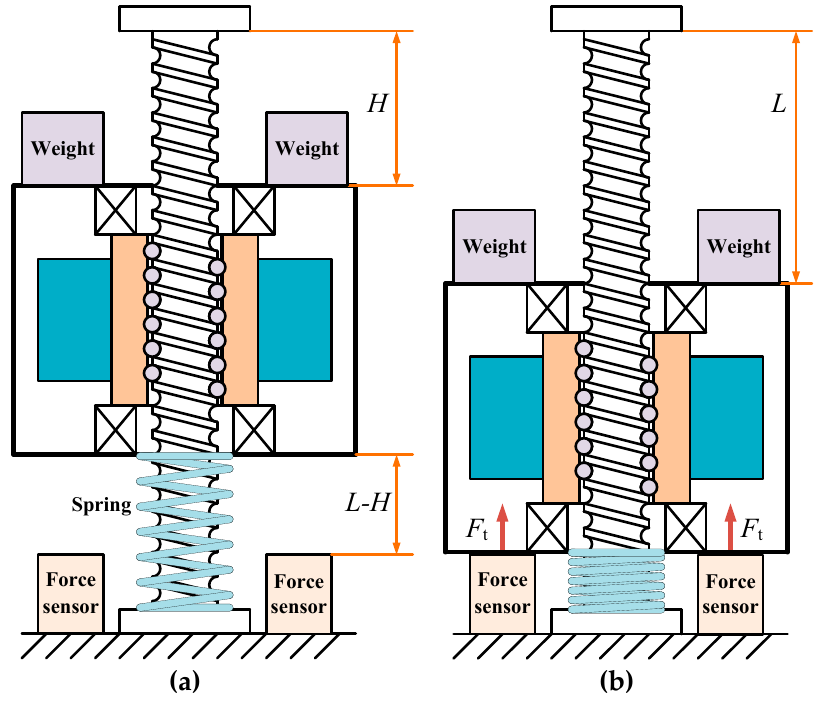
Figure 4. Diagram of the experiments of DBoBSI in ISD system. ( a ) Before dynamic-breakdown; ( b ) During dynamic-breakdown.